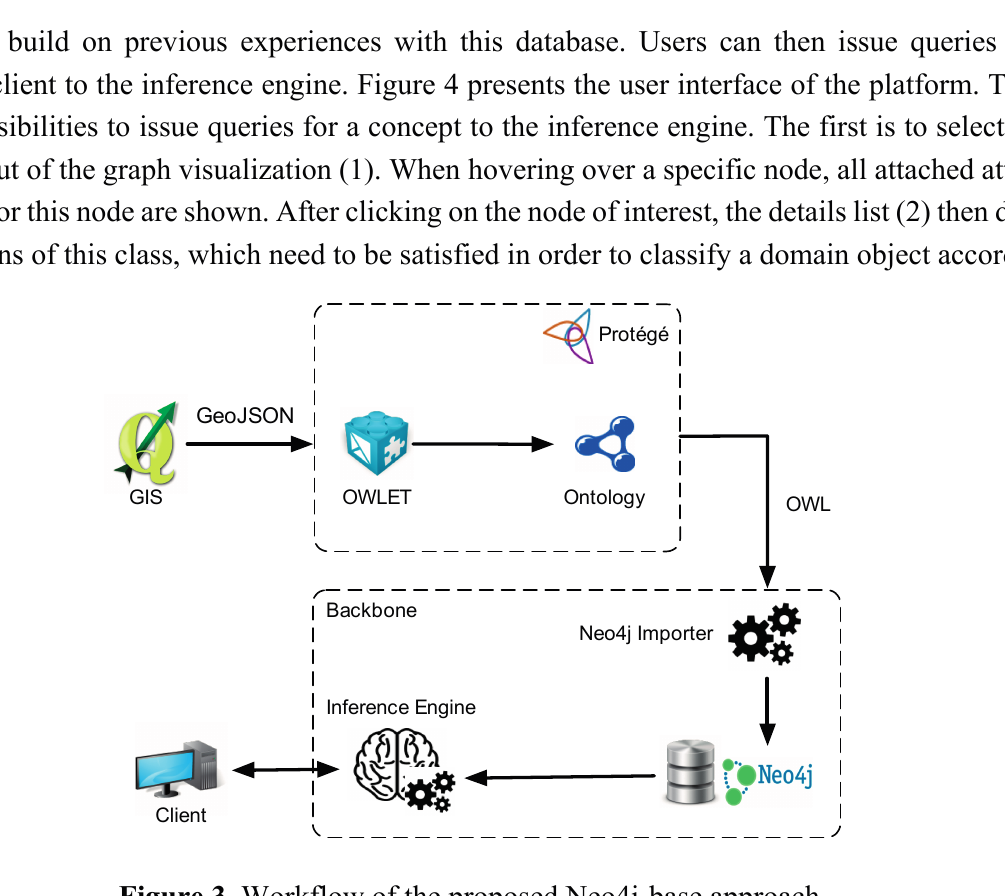
Figure 3. Workflow of the proposed Neo4j-base approach.